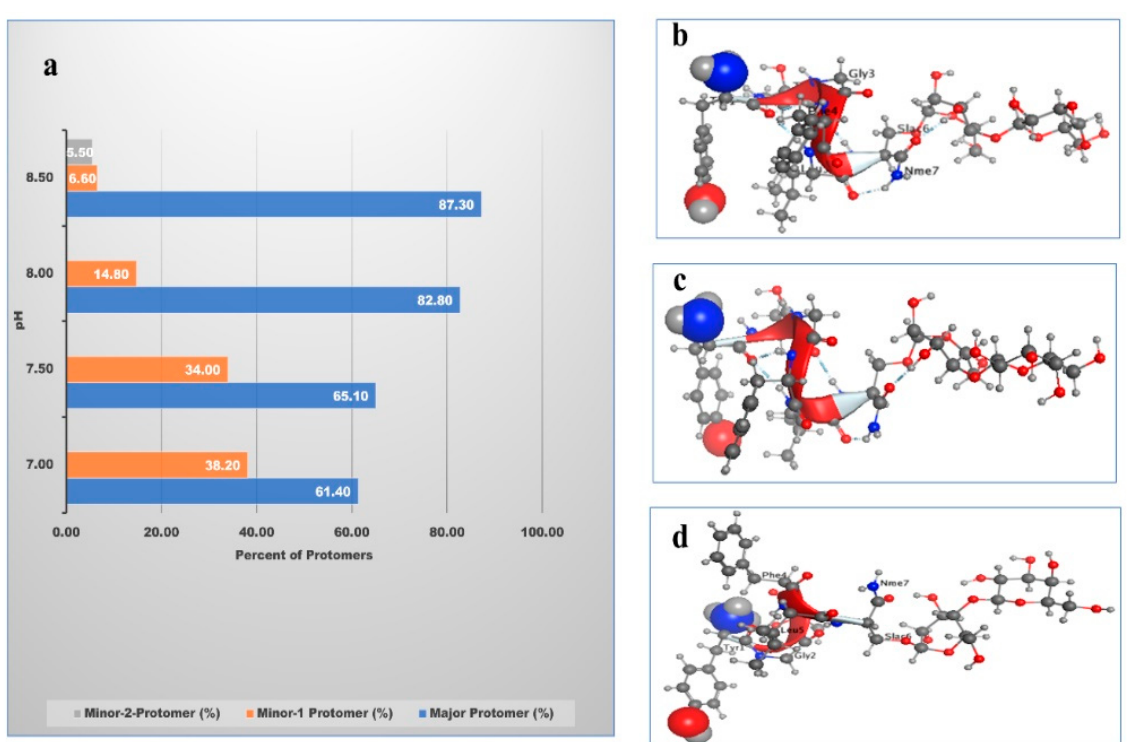
Figure 9. Computational pH titration of Lactomorphin ( a ). Protomers percentages at various pHs; ( b ). Major protomer 3D-structure; ( c ). Minor-1 protomer 3D-structure; ( d ). Minor-2 protomer 3D- structure.